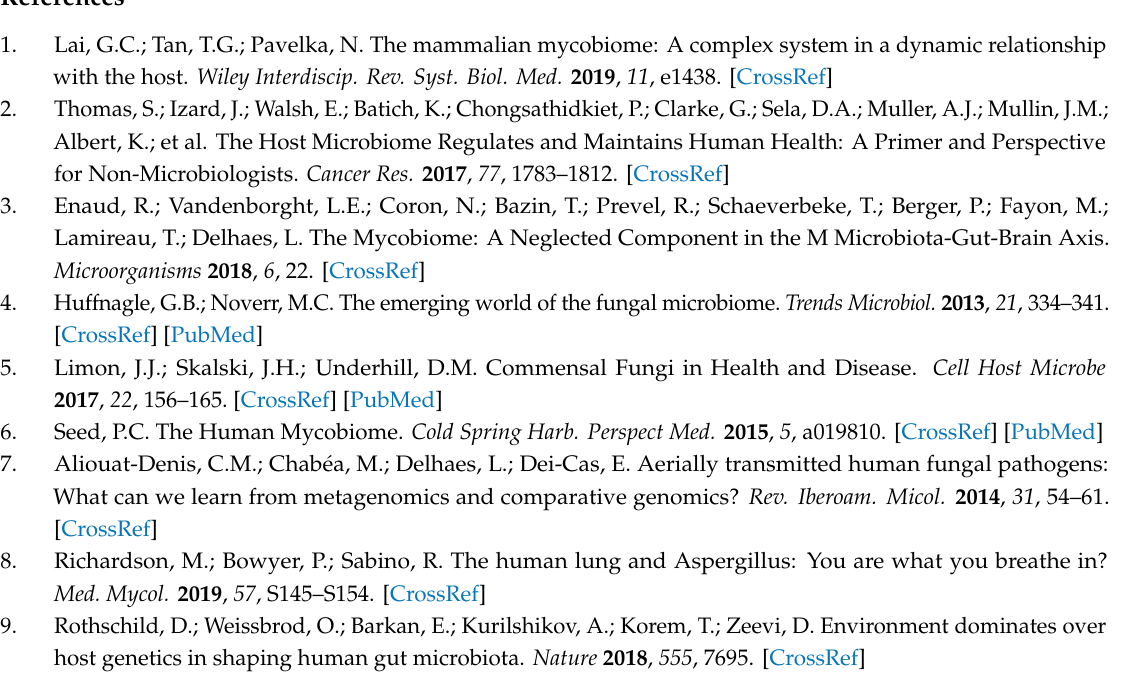
Table S1: patients & houses. Table S2: taxonomy of the identified OTUs. Table S3: cultures. Figure S1: Project work flow. Figure S2: Rarefaction curves. Document S1: patient data